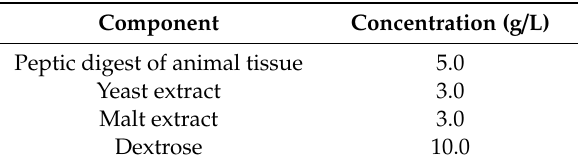
Table 1. Yeast Malt Broth (YM) medium